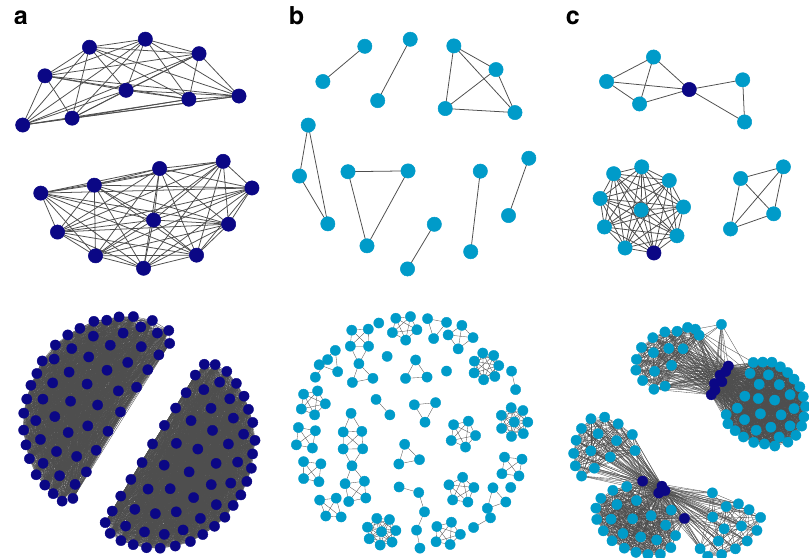
Fig. 1 Polarization through reputation. Emerging community networks in small ( n = 20, upper panel) and large ( n = 120, lower panel) populations of a Heider agents, b friend-focused agents, and c a majority of friend-focused agents (light blue dots) together with a minority (10%) of Heider agents (dark blue dots). Links between agents represent mutually positive relationships between two agents and hence a high likelihood to interact